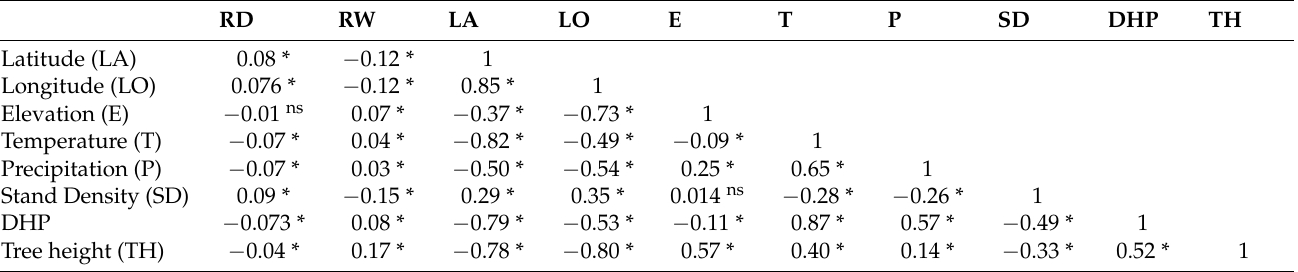
Figure 5. Variations of ( a ) average ring density (RD, kg m − 3 ), earlywood density (EWD, kg m − 3 ), latewood density (LWD, kg m − 3 ), ( b ) annual ring width (RW, mm), earlywood width (EWW, mm), latewood width (LWW, mm), and latewood proportion (LP, %) along a South–North latitudinal gradient in Abitibi Témiscamingue, Québec, Canada. Table 5. Correlation coefficients between annual ring density (RD) and annual ring width (RW) and ecological factors in Thuja occidentalis